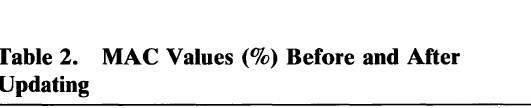
Table 2. MAC Values (%) Before and After Updating Mode